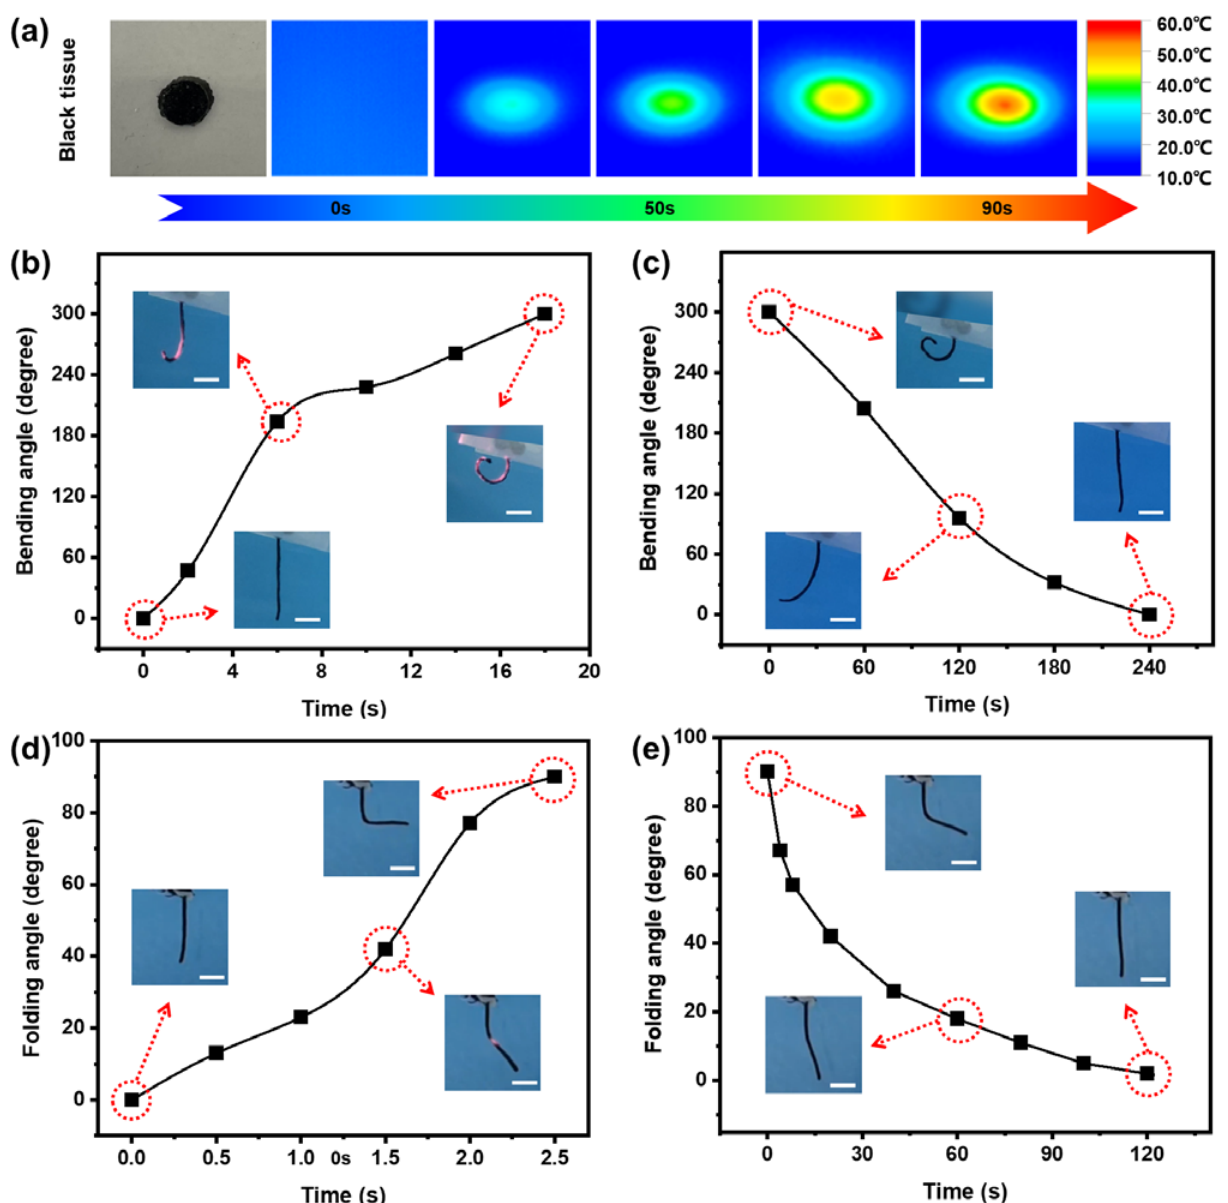
Figure 4. ( a ) Temperature change of tissue paper/PNIPAM hydrogel composite actuator in 15°C water under 3.5 W/cm 2 irradiation of the 808 NIR area light. The ( b ) bending (change of central angle, under 3.5 W/cm 2 irradiation) and the ( c ) recovering process of the tissue paper/PNIPAM hydrogel composite actuator with an area NIR irradiation. The ( d ) folding (change of the angle between the two sides under a 0.2 cm spot diameter and 2 W of power by an 808 nm laser lamp, 63.9 W/cm 2 ) and the ( e ) recovering process of the tissue paper/PNIPAM hydrogel composite actuator with a point NIR irradiation.